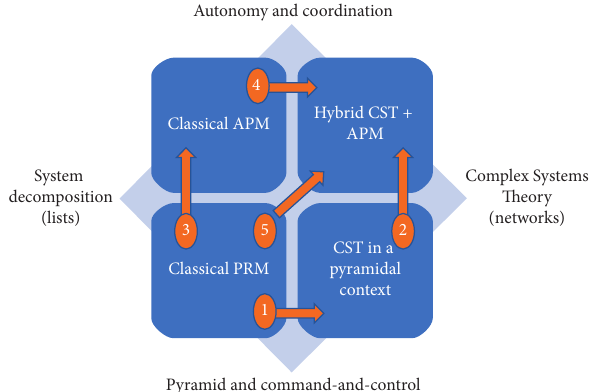
Figure 1: Illustration of the diagram of possible paths towards combination of CST and APM into